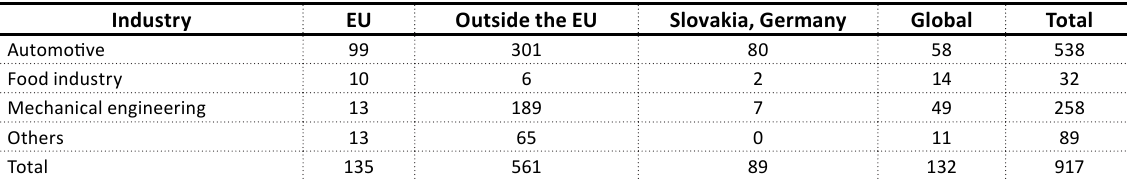
Table 7. Diversification of export territories and structure of